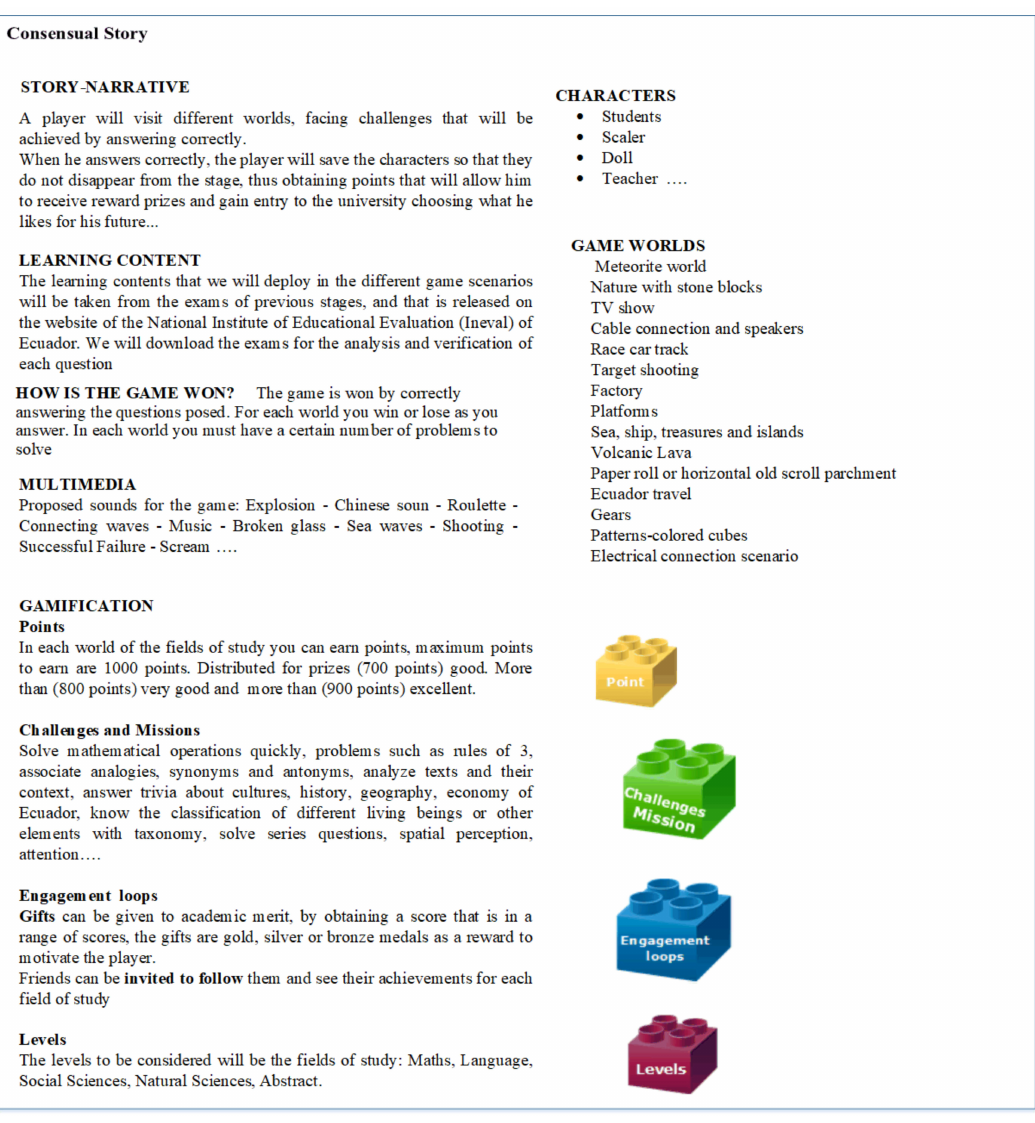
Figure 13. Consensual Game